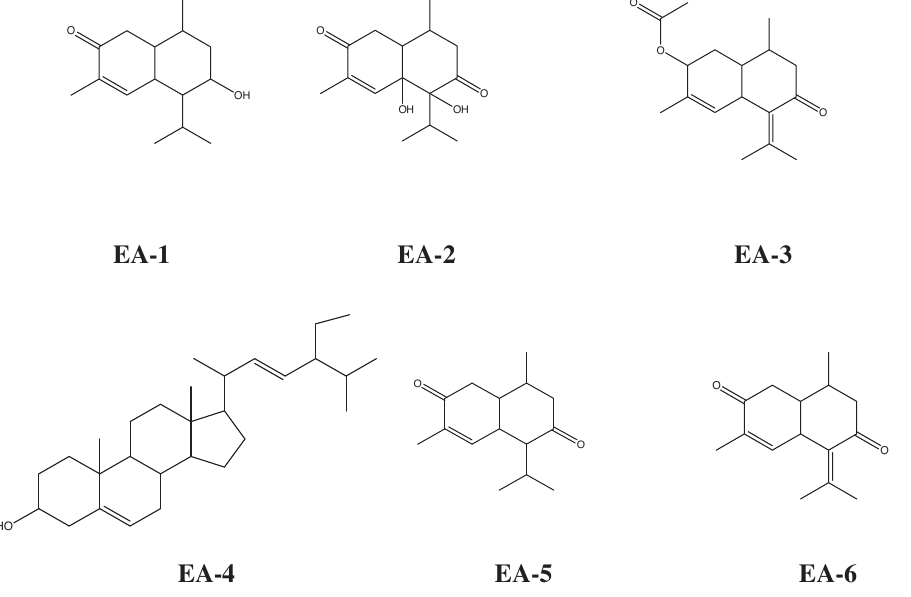
Fig. 1: Structures of terpenes isolated from E. adenophorum leaves. (